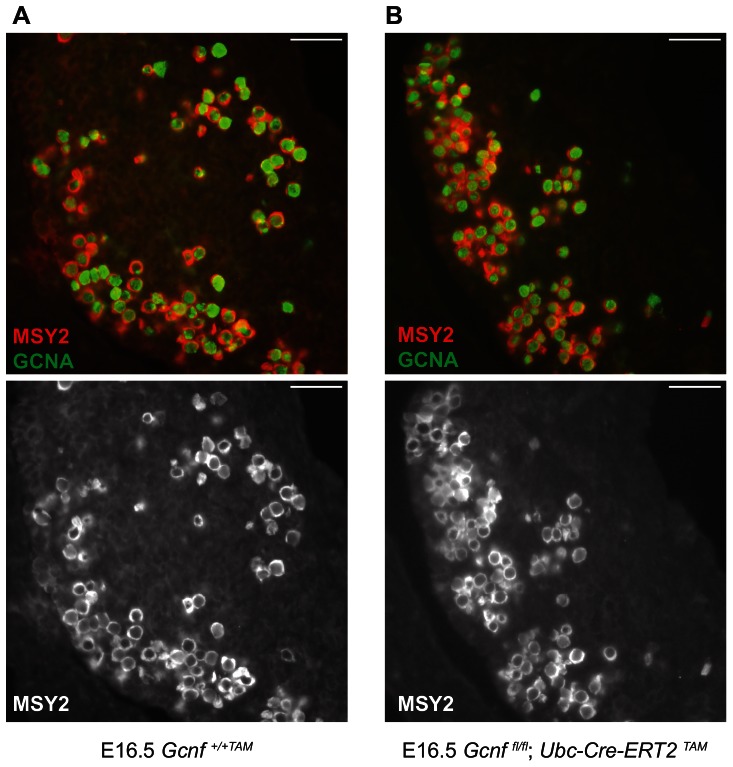
Gcnf mutants initiate oogenesis.Immunostaining for MSY2 (red) and GCNA (green) in Gcnf+/+TAM wild-type (A) and Gcnffl/fl;Ubc-Cre-ERT2TAM mutant (B) ovaries at E16.5. Anterior is to the left. Scale bar, 50 um.